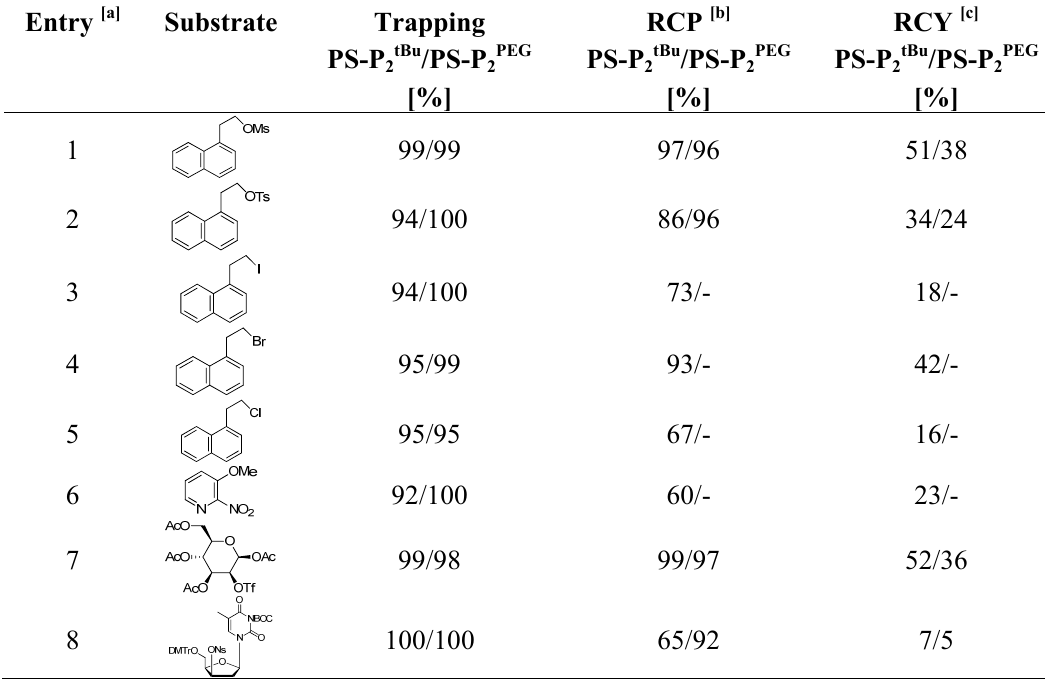
Table 6. Radiofluorination with P -P 2tBu and P -P 2PEG : The substrate